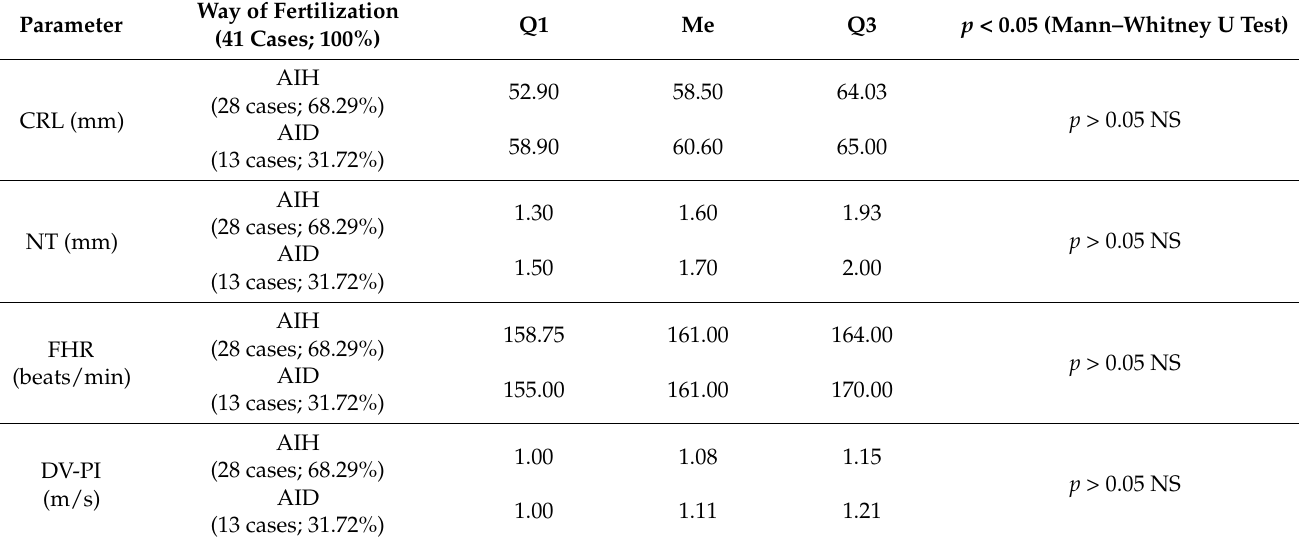
Table 3. Assessment of the parameters describing the growth and health of the fetus without a congenital heart defect based on ultrasound examination in a group of women who became pregnant as a result of Artificial insemination by Husband or